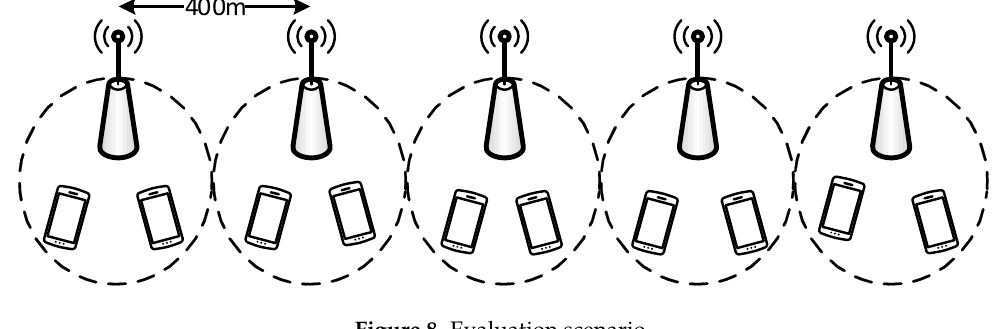
Figure 8. Evaluation scenario. Table 1. Physical-layer parameters. ITU: International Telecommunication Union; eNB: eNodeB; UE: User Equipment; UL: uplink; D2D: